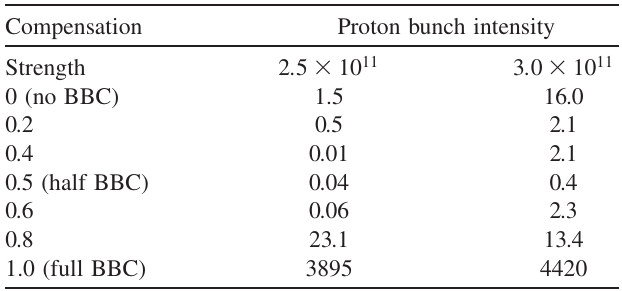
TABLE III. Proton beam loss rates (in units of %/hour) in the scan of head-on beam-beam compensation strength.